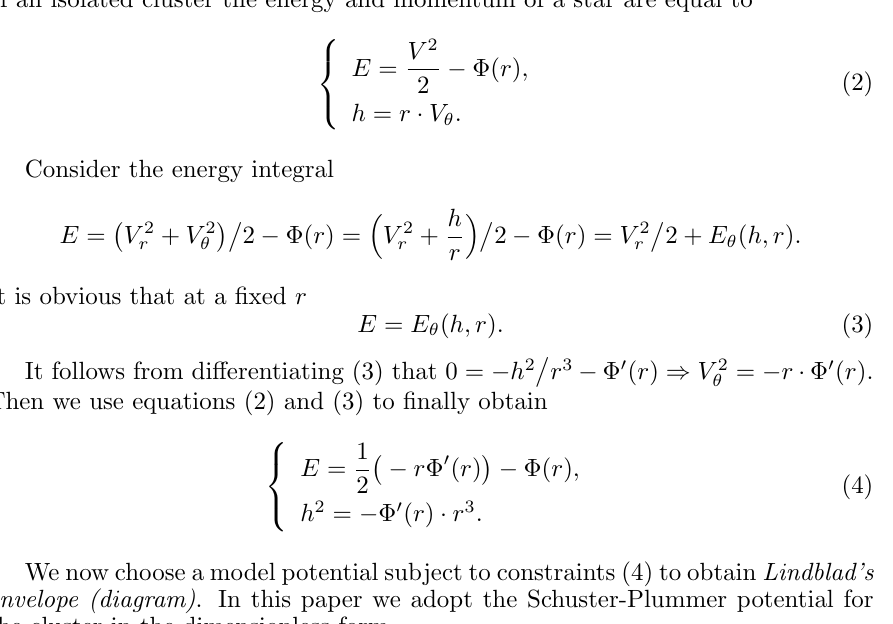
In the case of an isolated cluster, the values of integrals corresponding to the Lindblad’s envelope refer to the motion of a given star relative to the circular orbit. Negative and positive values of the area integral correspond to retrograde and regular orbits, re-